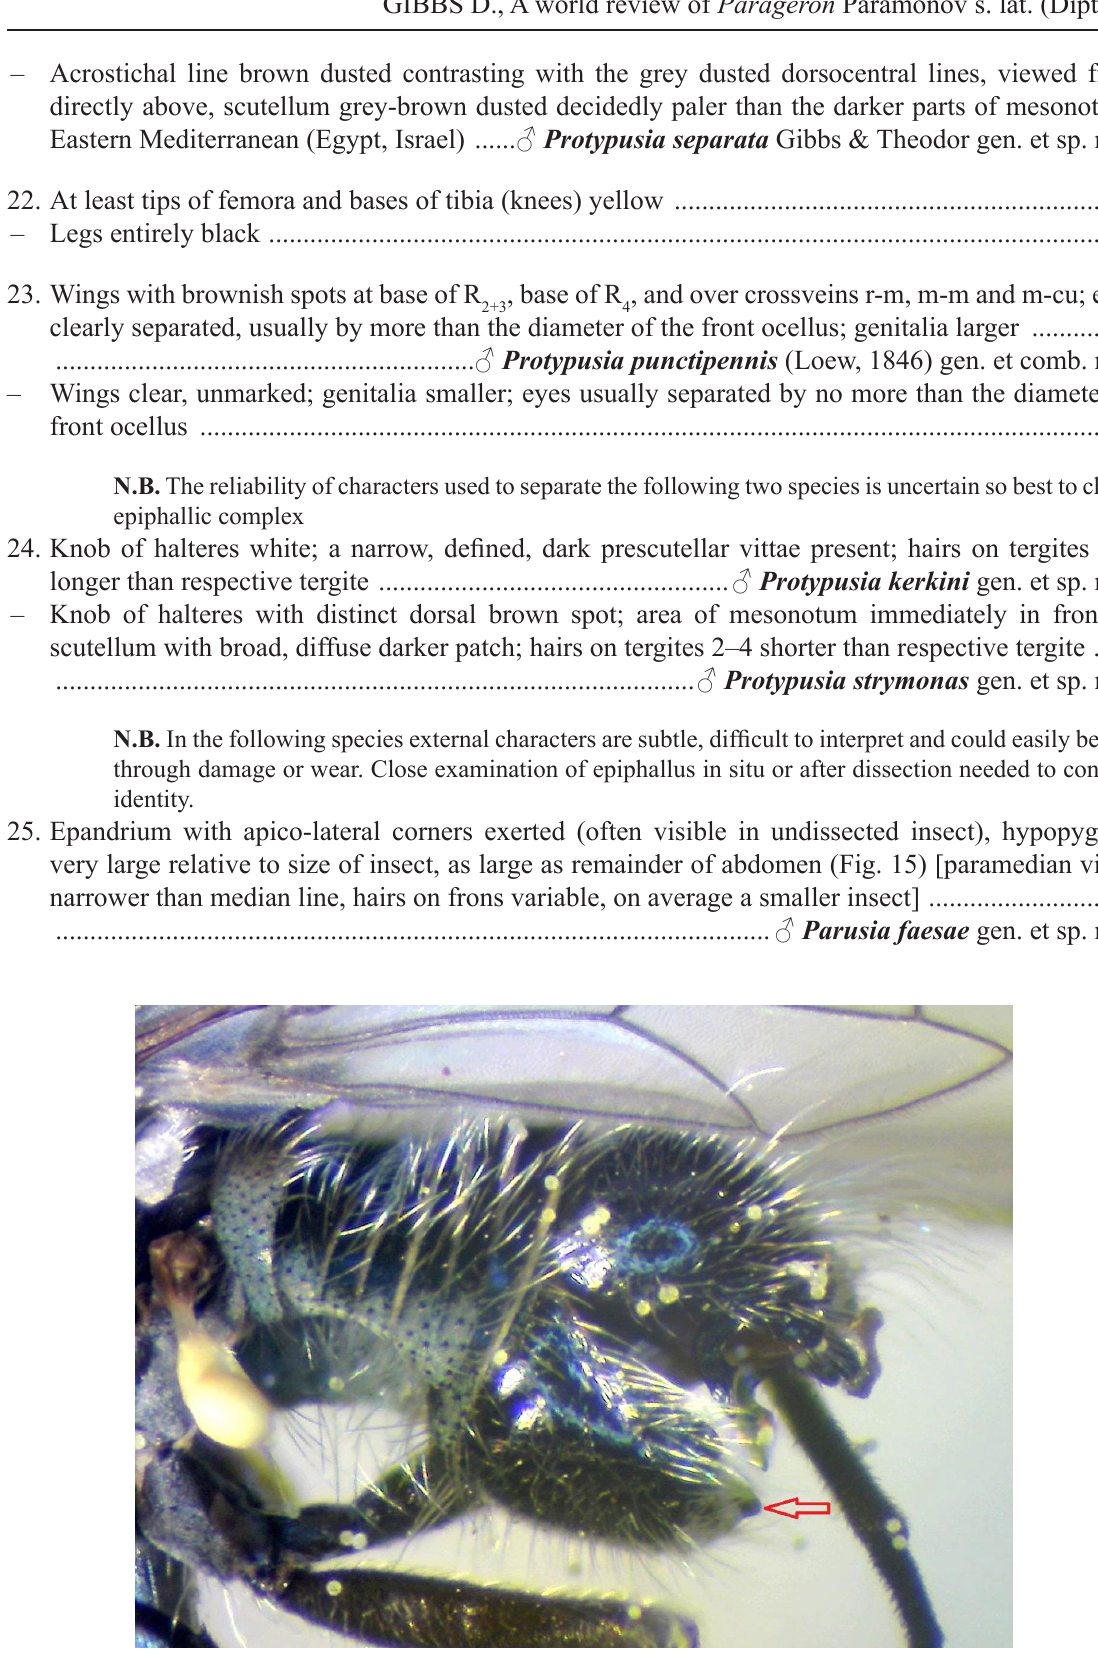
Fig. 15. Parusia faesae gen. et sp. nov.,